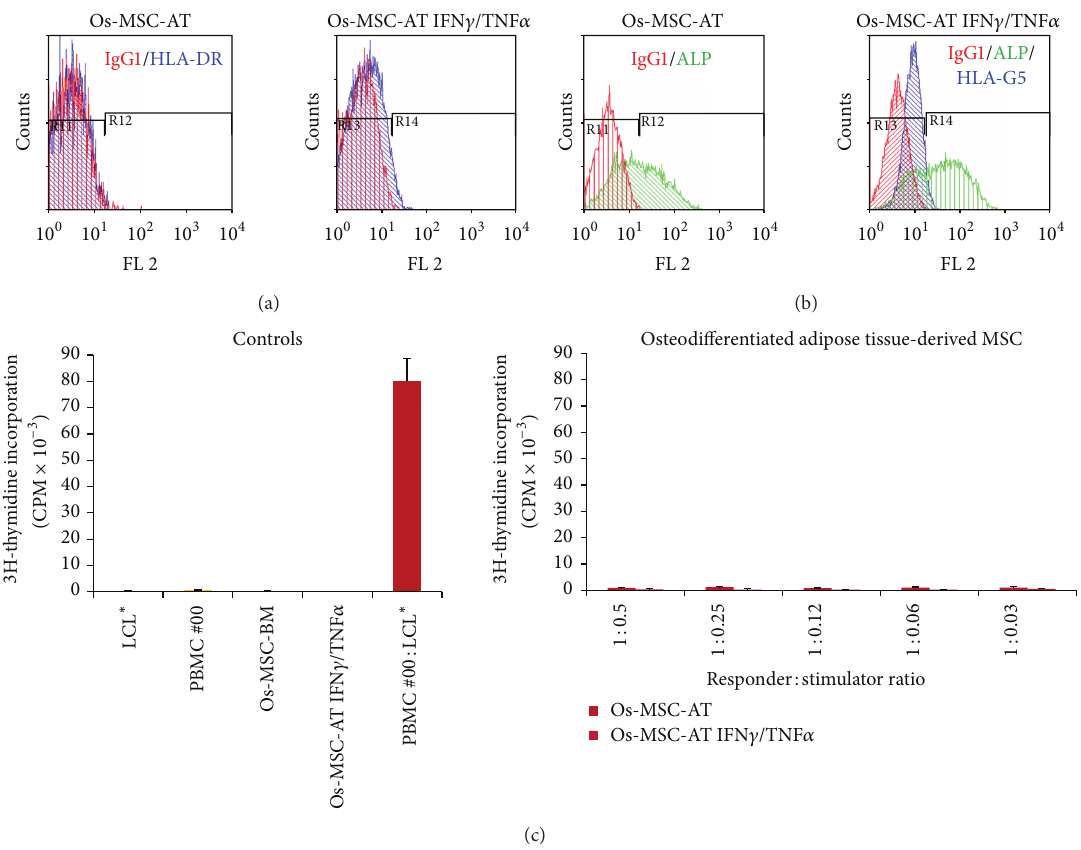
Figure 4: AT-derived MSCs committed to osteodifferentiation process express HLA-G and are hypoimmunogenic. (a) Expression of HLA- DR molecules was evaluated by flow cytometry analysis on AT-derived MSCs committed to 14-day osteodifferentiation process and pretreated with IFN 𝛾 and TNF 𝛼 (Os-MSC-AT IFN 𝛾 /TNF 𝛼 ) or not (Os-MSC-AT). (b) Expression of ALP and HLA-G5 was evaluated by intracellular flow cytometry analysis on AT-derived MSCs committed to 14-day osteodifferentiation process and pretreated with IFN 𝛾 and TNF 𝛼 (Os- MSC-AT IFN 𝛾 /TNF 𝛼 ) or not (Os-MSC-AT). IgG1 was used as isotype control Ab. (c) PBMC from healthy individual (#00) were used as responder cells towards AT-derived MSCs committed to osteodifferentiation process and pretreated with IFN 𝛾 and TNF 𝛼 (Os-MSC-AT IFN 𝛾 /TNF 𝛼 ) or not (Os-MSC-AT) as stimulating cells at various responder:stimulator ratios. Irradiated LCL ∗ were used as positive control of T cell alloproliferation. Results are given as mean cpm ± s.e.m.; one representative experiment is